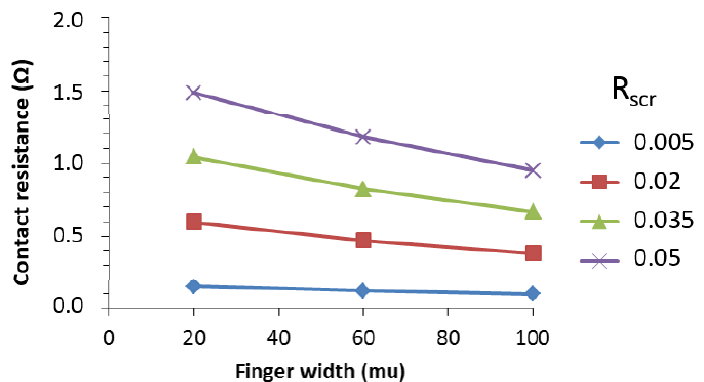
Figure 9. Contact resistance for a cell of 1 cm 2 for a cell with metal interconnect and fingers as a function of the finger width for various specific contact resistances (R scr , in Ω cm 2 ). Ω 2.5. Impact of Contact Resistance on Cell Performance.